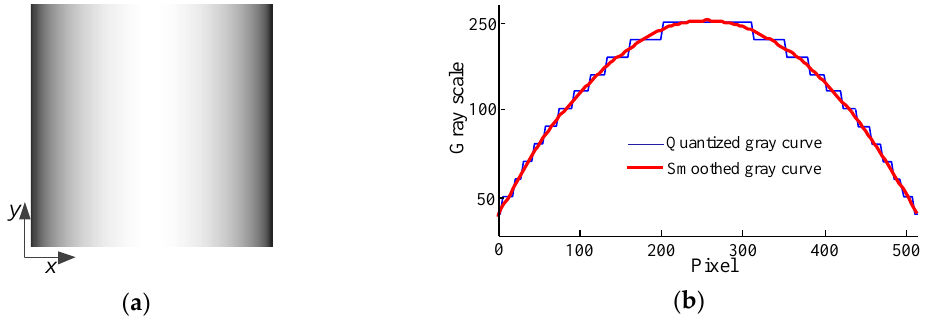
Figure 3. ( a ) Semi-cylindrical image; and ( b ) Gray curve in the x -direction.